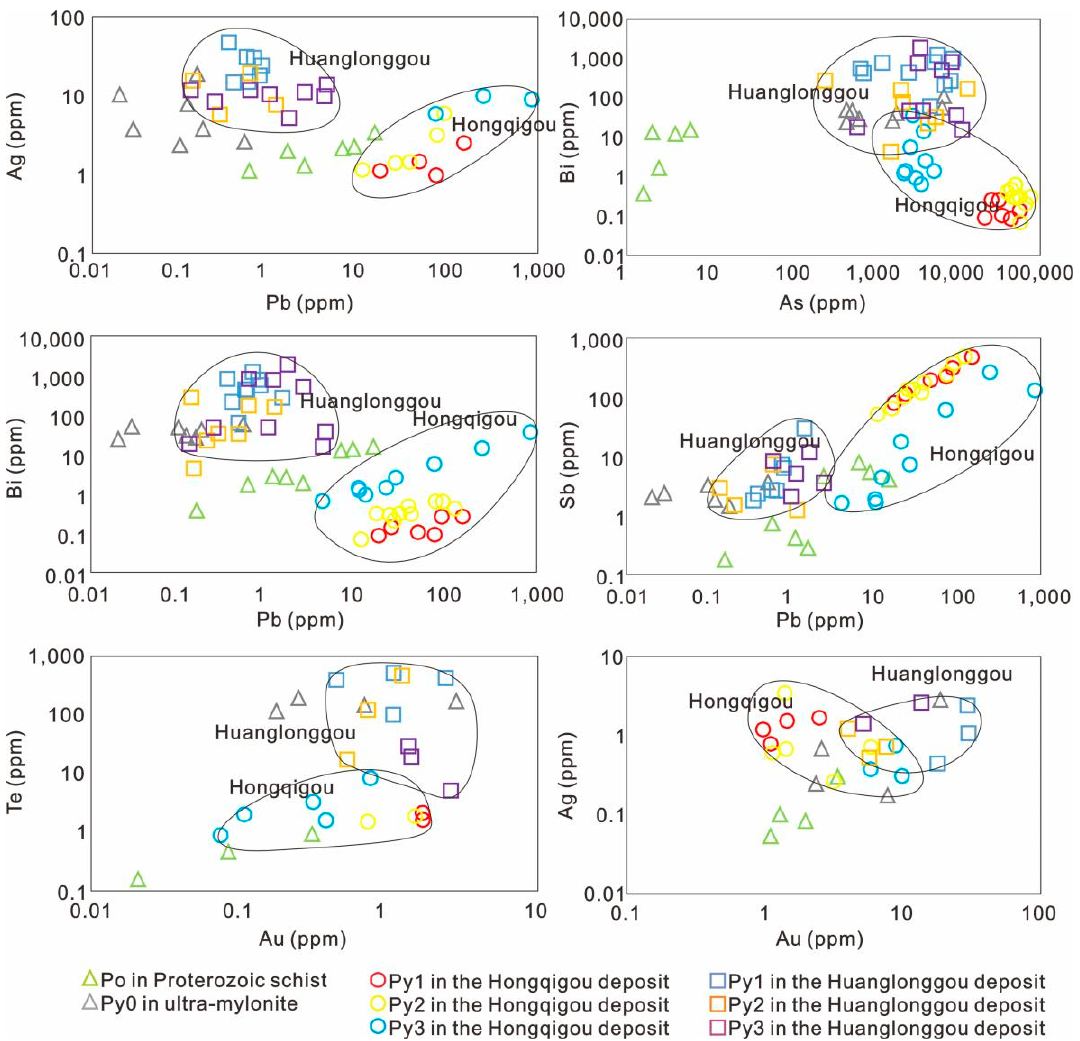
Figure 13. The selected binary plots showing the geochemical characteristics of pyrite from each stage of ores in the Hongqigou and Huanglonggou deposits, ultra-mylonite, and pyrrhotite in schist of wall rock.